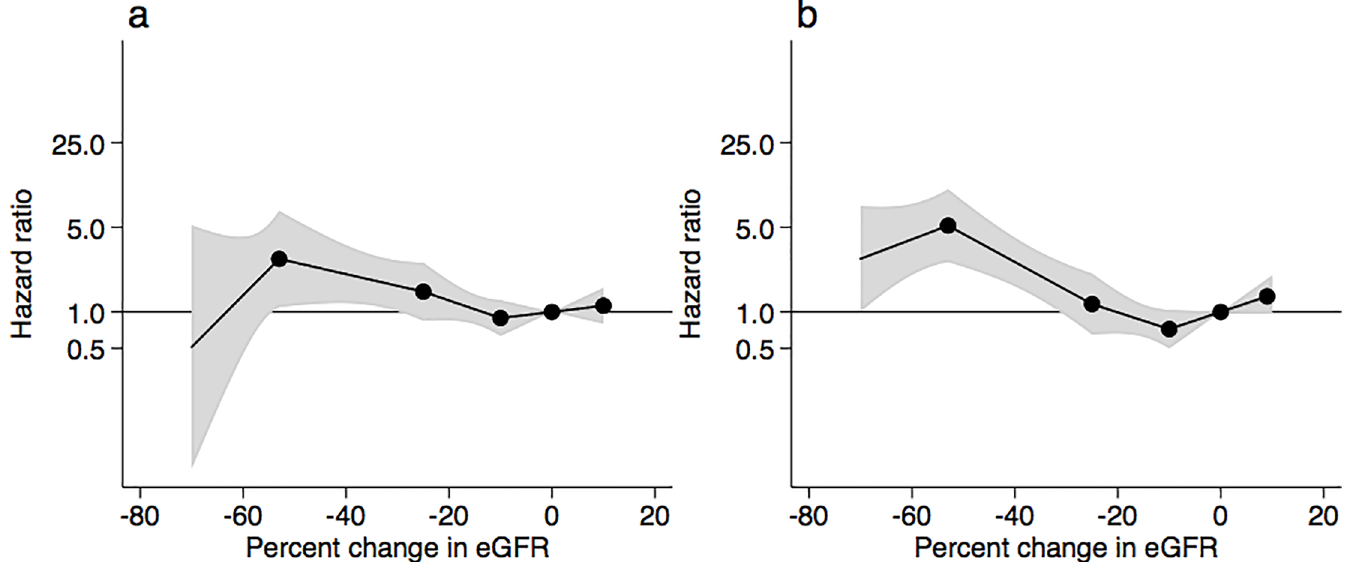
Fig 5. Adjusted hazard ratios of all-cause mortality according to percent changes in eGFR during the (a) 2-year or (b) 3-year baseline period. The model was adjusted for gender, age, systolic blood pressure, baseline eGFR, baseline urinary albumin, and history of cardiovascular disease. Knots were placed at − 53%, − 25%, − 10%, and 10%. A reference point was set at 0% change in eGFR. Value trimmed at less than − 70% and > 10% change in